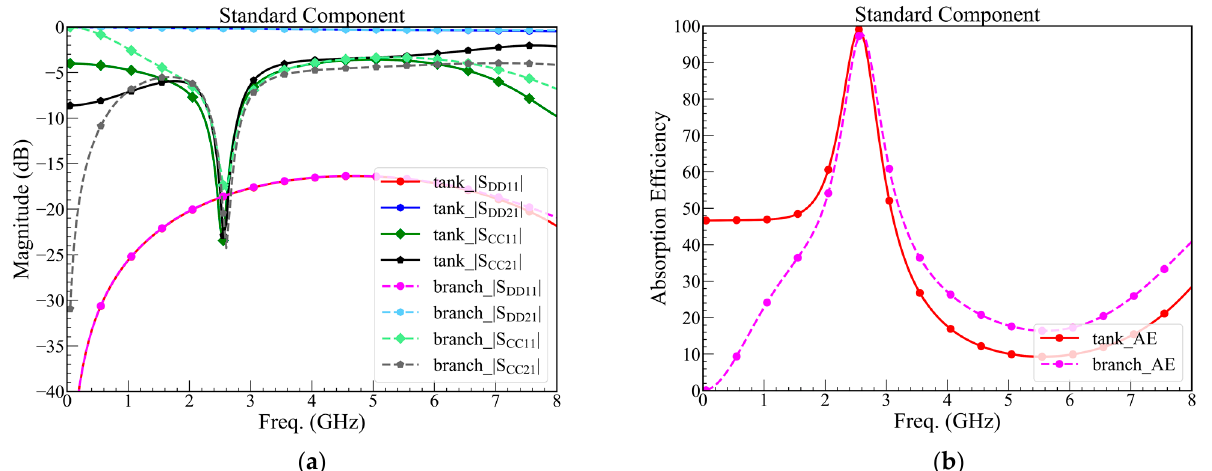
Figure 9. ( a ) Mixed-mode S -parameters of the proposed design with standard components, and ( b )